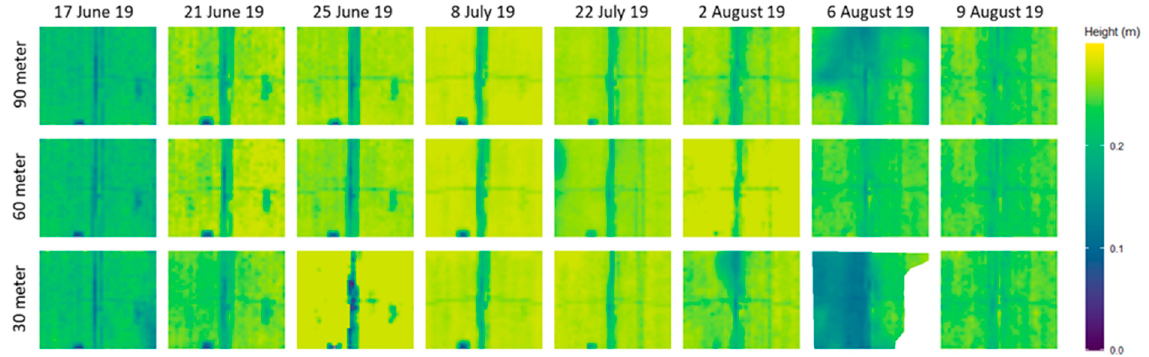
Figure A3. Canopy height (m) raster maps derived from Enhanced Vegetation Index for each mis- sion.